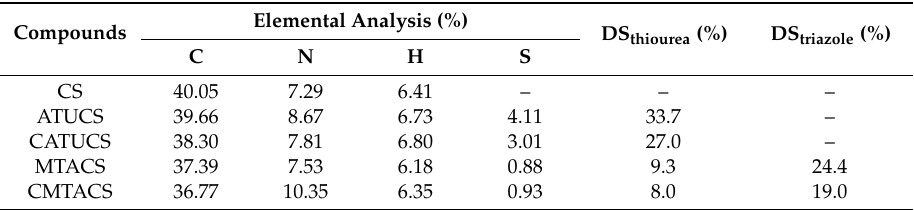
Table 1. Elemental analysis results and degree of substitution of chitosan (CS), acetyl thiourea chitosan (ATUCS), 3-methyl-1,2,4-triazolyl chitosan (MTACS), chloracetyl thiourea chitosan (CATUCS), and 3-chloromethyl-1,2,4-triazolyl chitosan (CMTACS) derivative.